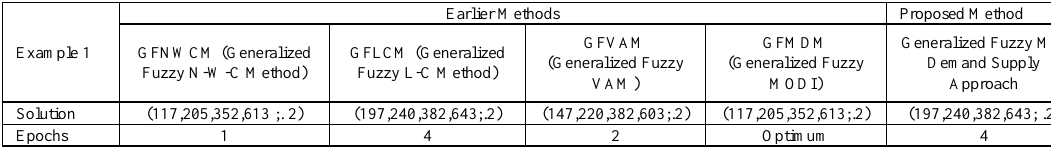
Table 9. Comparison based on optimal solution and epochs (Example 1)